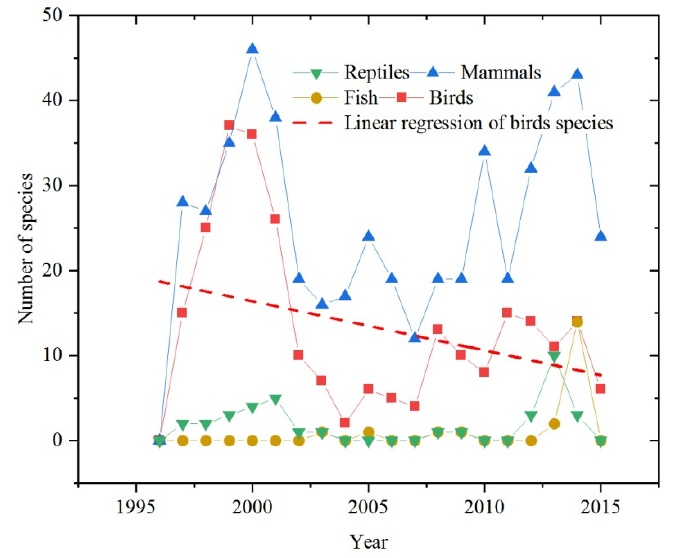
Figure 3. Annual variation in the number of imported species of different classes in China.